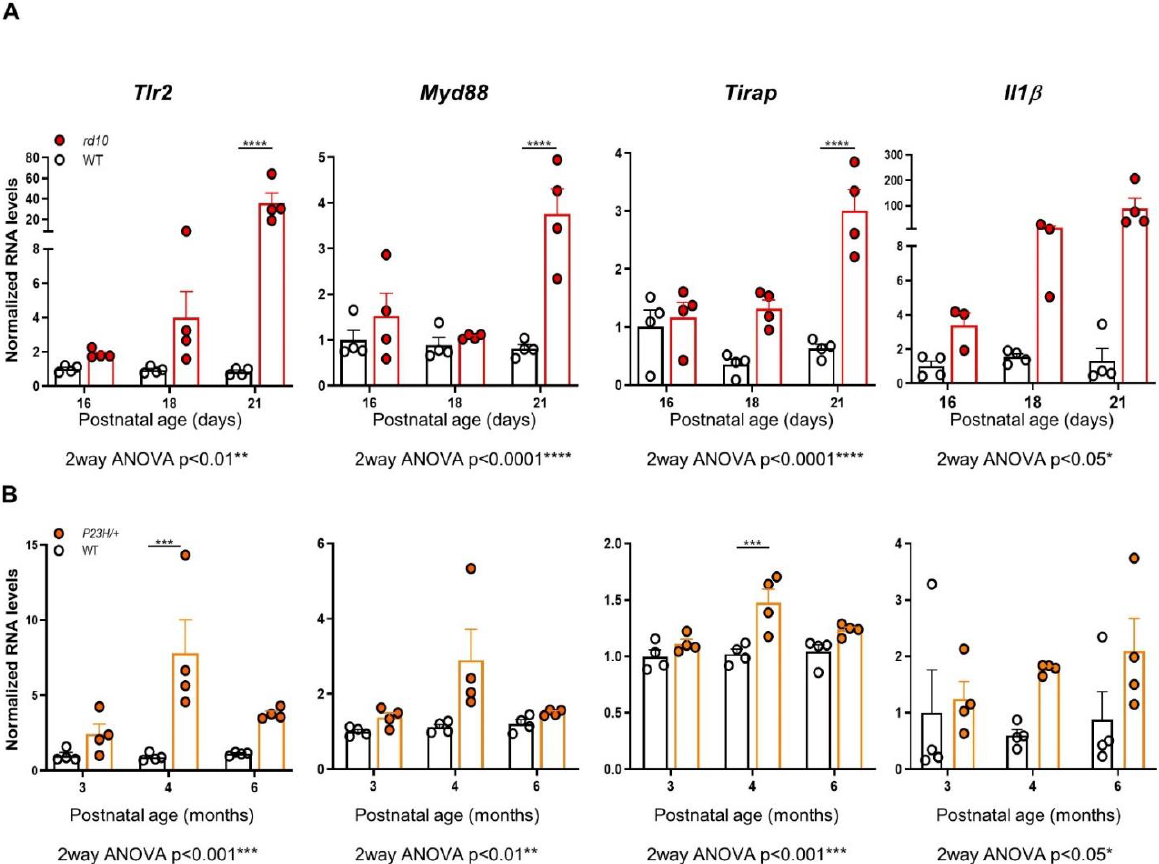
Figure 1. Expression of Tlr2 , TLR adaptor genes, and Il1b in WT, rd10, and P23H/+ retinas. Gene expression of Tlr2, the adaptors of the MyD88-dependent pathway Myd88 and Tirap, and Il1b was analyzed by RT-qPCR of individual retinas from WT and rd10 mice ( A ), and WT and P23H/+ mice ( B ), at the indicated ages. Dots represent individual animals, and bars represent the mean (+SEM) for each group ( n = 4 per group). Data were normalized to Tbp RNA and expressed relative to WT levels at 16 days (for rd10 mice) or to WT levels at 3 months (for P23H/+ mice). Gene expression was compared between genotypes at different time points, using 2way ANOVA, followed by Sidak’s multiple comparison test in cases in which significant interactions between age and genotype were detected. **** p < 0.0001; *** p < 0.001; ** p < 0.01; * p < 0.05.